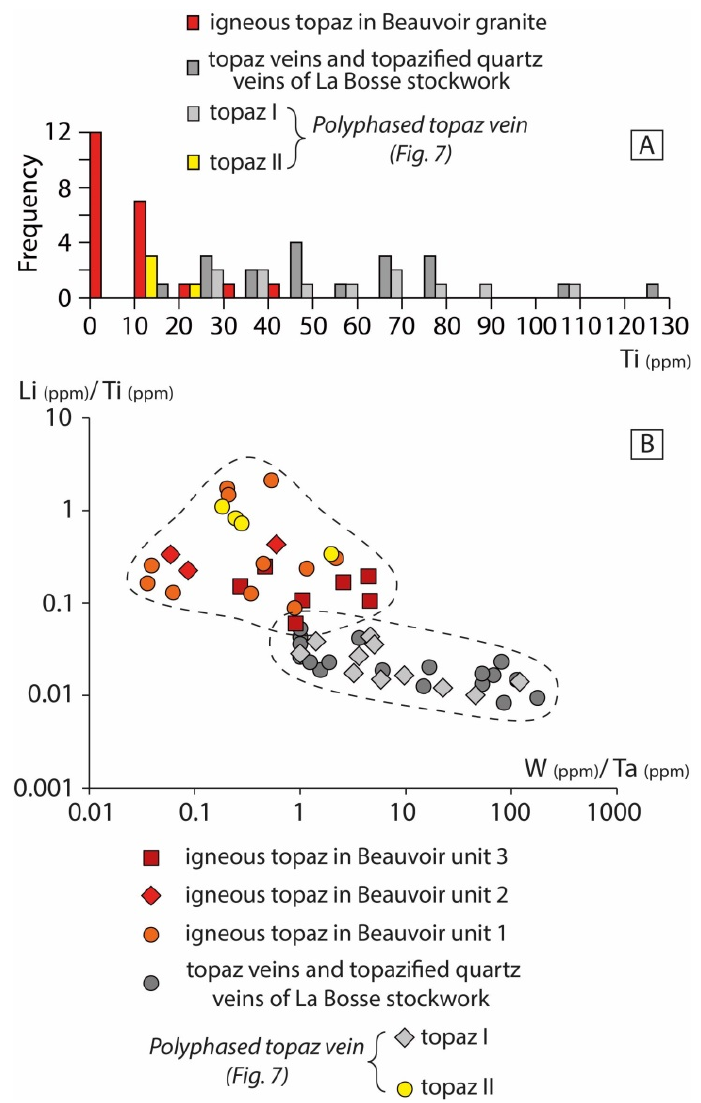
Figure 12. ( A ): A frequency histogram showing the variation of Ti content in the di ff erent topaz types, determined by LA-IC-PMS analyses. ( B ): A binary plot of Li / Ti vs W / Ta, which allows to distinguish two groups of topaz: igneous topaz from Beauvoir granite plus the hydrothermal topaz II generation from the polyphased topaz vein in the La Bosse stockwork (Figure 7), and all other topaz occurrences from the stockwork (including topaz I from the polyphased vein, and vein topaz and from topazified quartz veins). See [24] for a description of Beauvoir units 1 to 3.